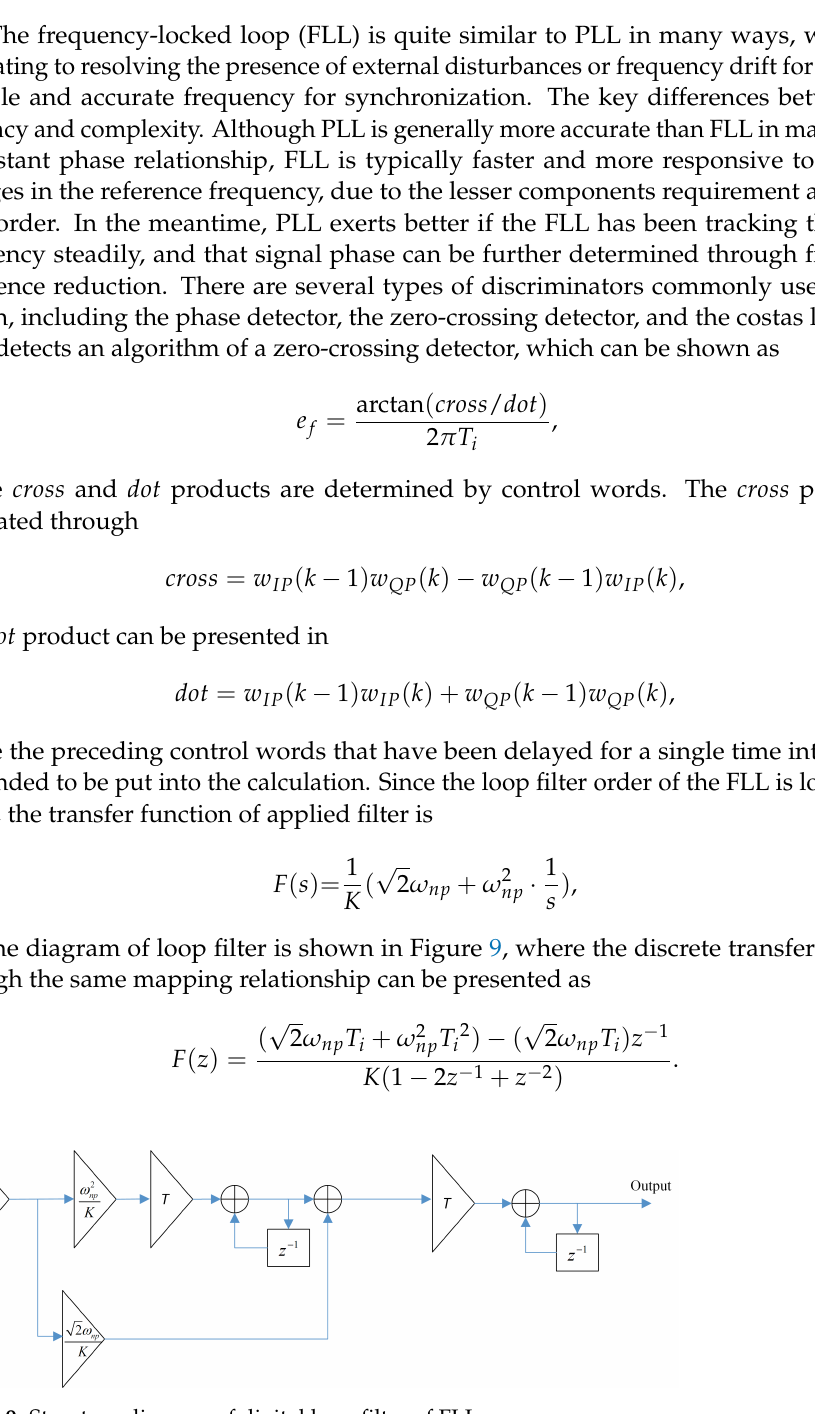
Figure 9. Structure diagram of digital loop filter of